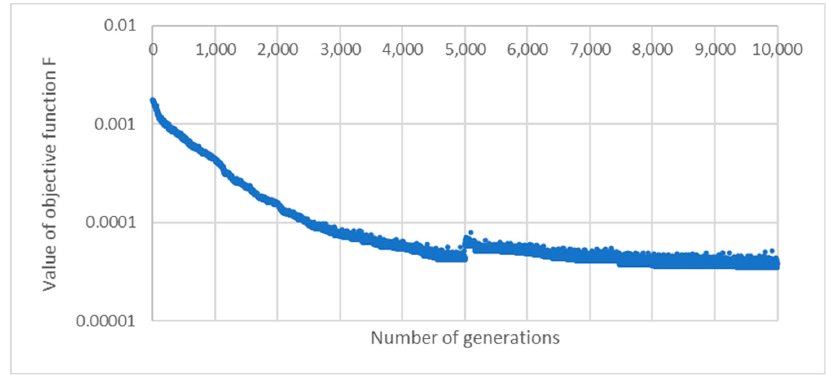
Figure 5. Objective function value against the number of evolution strategy generations for Case 1.1.